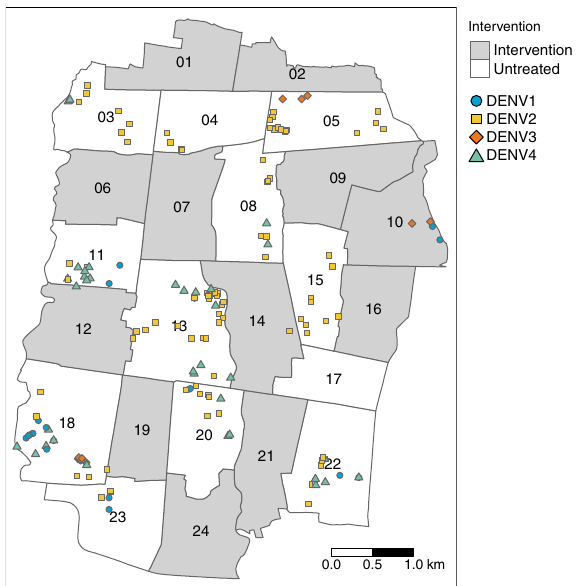
Figure 5. Residential locations of the 160 enrolled serotyped dengue cases involved in homotypic pairs with residences within 300 m and illness onset within 30 days, including pairs that cross cluster